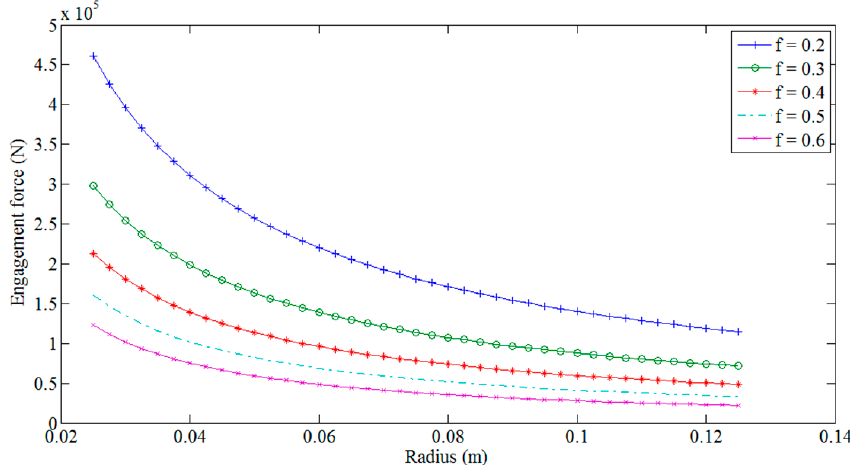
Figure 6. Required engagement force to maintain 400 nm holding torque over a range of radii and surface coefficient of frictions.